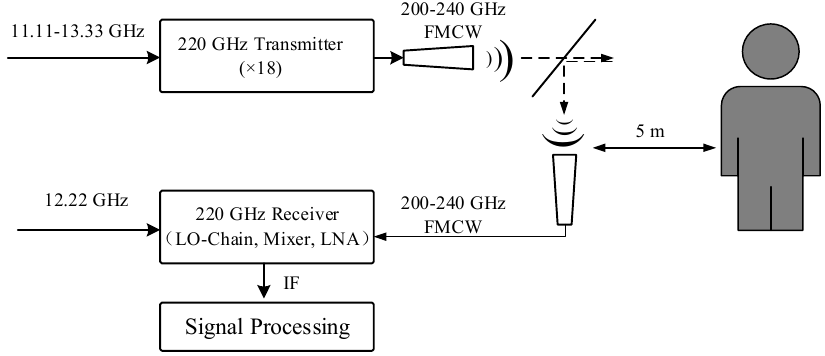
Figure 22. Schematic diagram of the 220 GHz remote sensing imager.